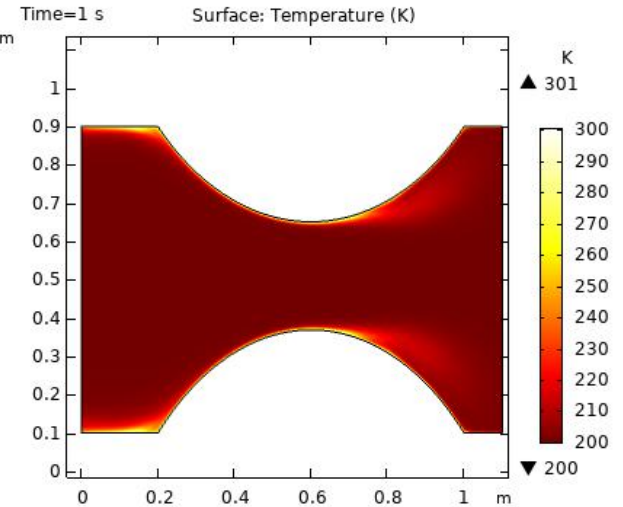
Figure 13. The temperature profile at t = 1 s.